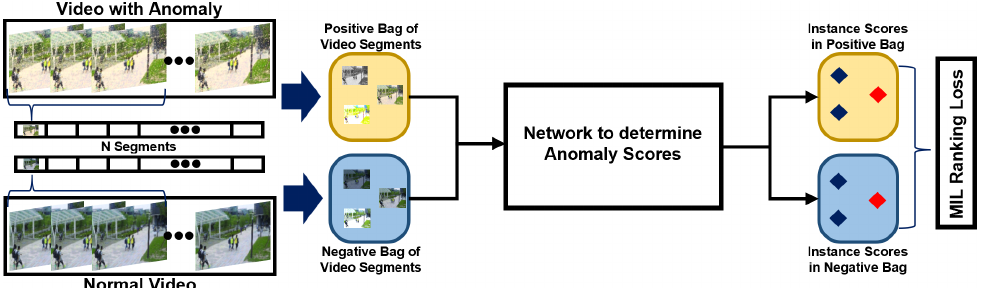
Figure 2. Architecture of a typical MIL-based method, such as the one proposed by Sultani et al. [40].